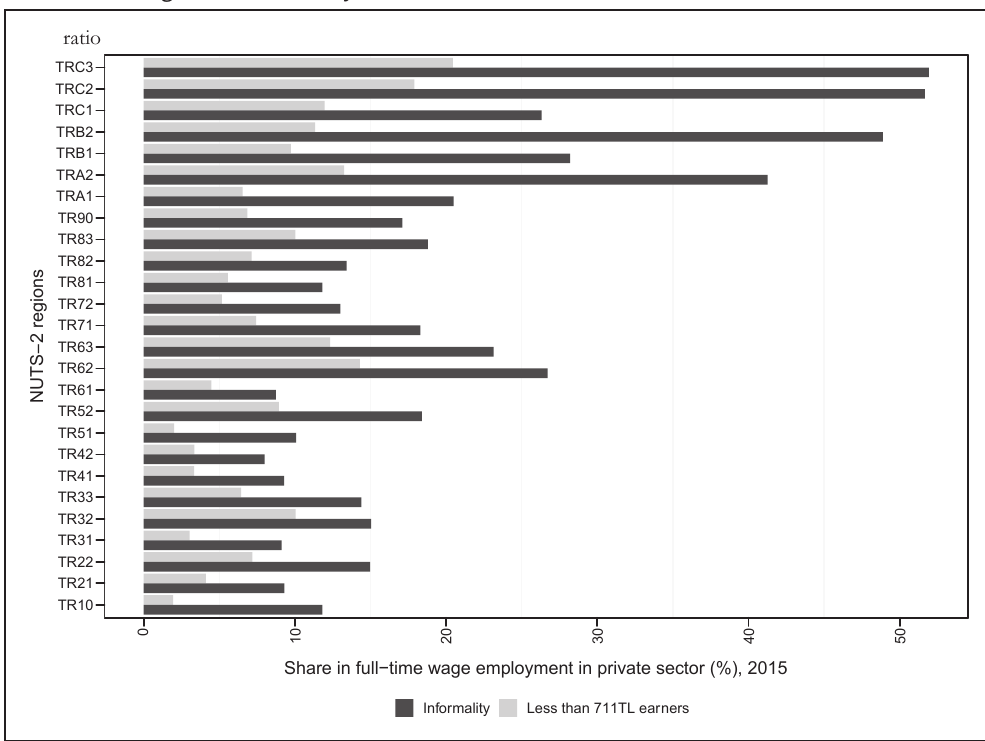
Figure A7 The regional fraction of workers earned less than 711 Turkish liras and the regional informality